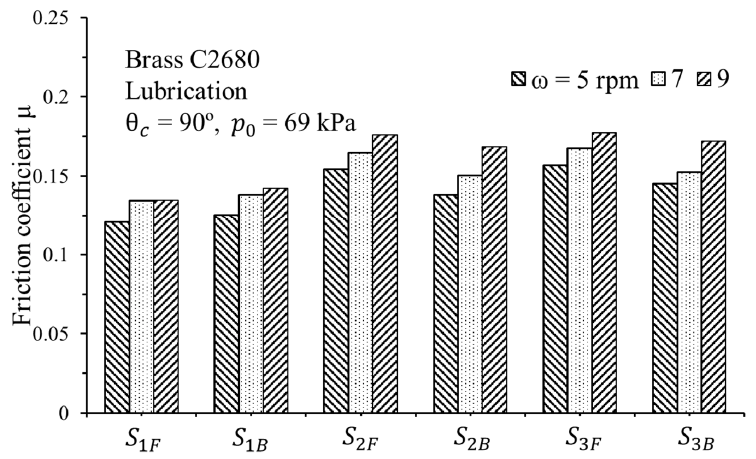
Figure 10. E ff ects of rotation speed on friction coe ffi cient under lubricated Figure 10. Effects of rotation speed on friction coefficient under lubricated conditions.